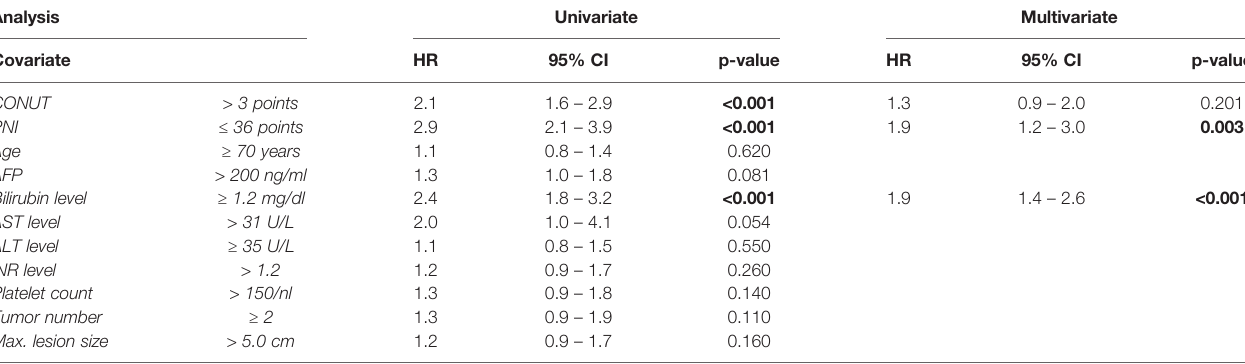
TABLE 2 | Univariate and multivariate Cox proportional hazards regression models evaluating PNI, CONUT, and other risk factors for the entire patient cohort (n=237). Analysis